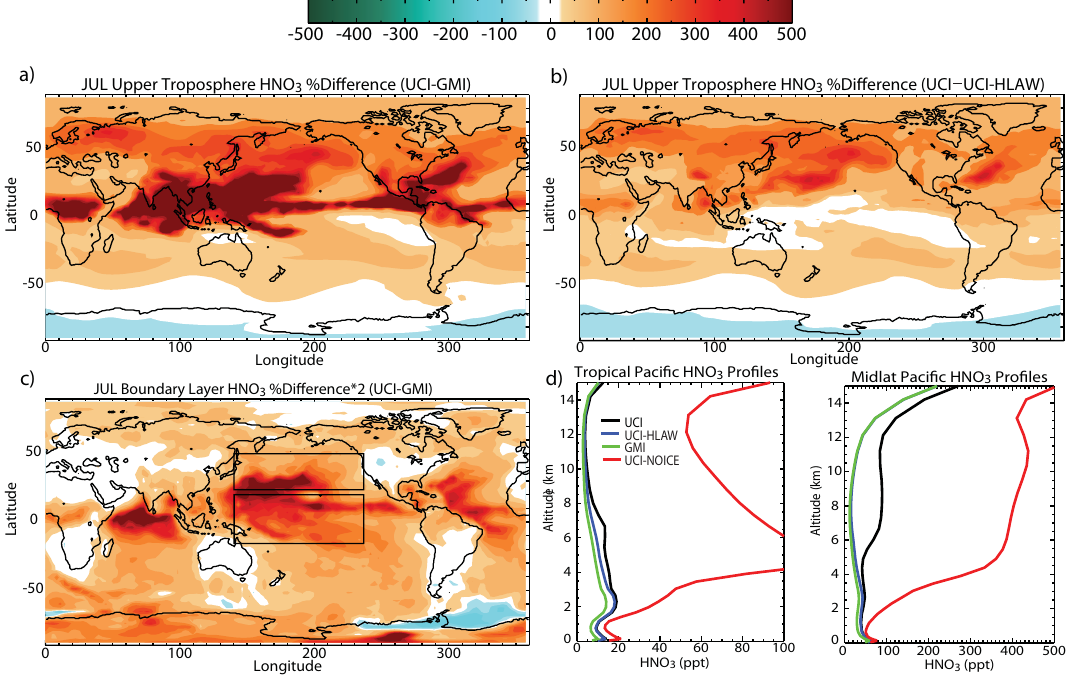
Fig. 3. (a) Latitude-longitude cross section of the percent difference between UCI and GMI (UCI-GMI/UCI) HNO 3 averaged over the upper troposphere (150hPa <p < 500hPa) for July. Contour range is − 500 to 500%. (b) Same as (a) but for the percent difference between UCI and UCI-HLAW. (c) Same as (a) , but HNO 3 is averaged over the boundary layer ( p > 850hPa) and the percent difference is multiplied by 2 to allow use of the same contour interval. (d) Profiles of HNO 3 (ppt) from the UCI (black), UCI-HLAW (blue), GMI (green), and UCI-NOICE (red) simulations, averaged over the Tropical Pacific and Midlatitude Pacific boxes shown in (c) .